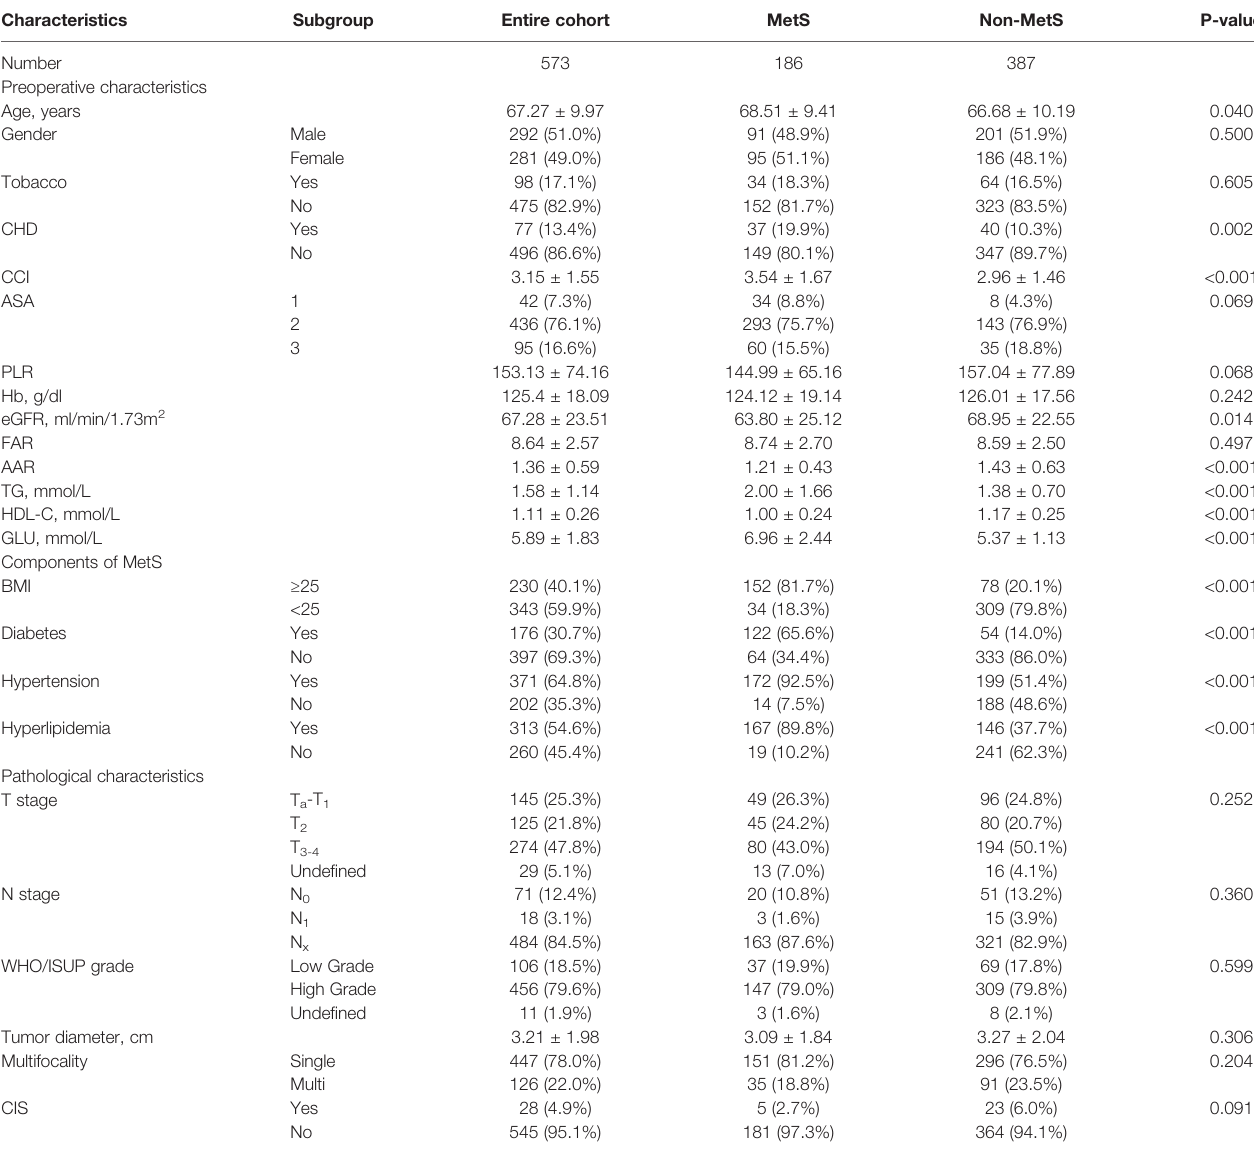
TABLE 1 | Clinicopathological characteristics of the entire cohort and subgroups according to MetS before propensity score matching.